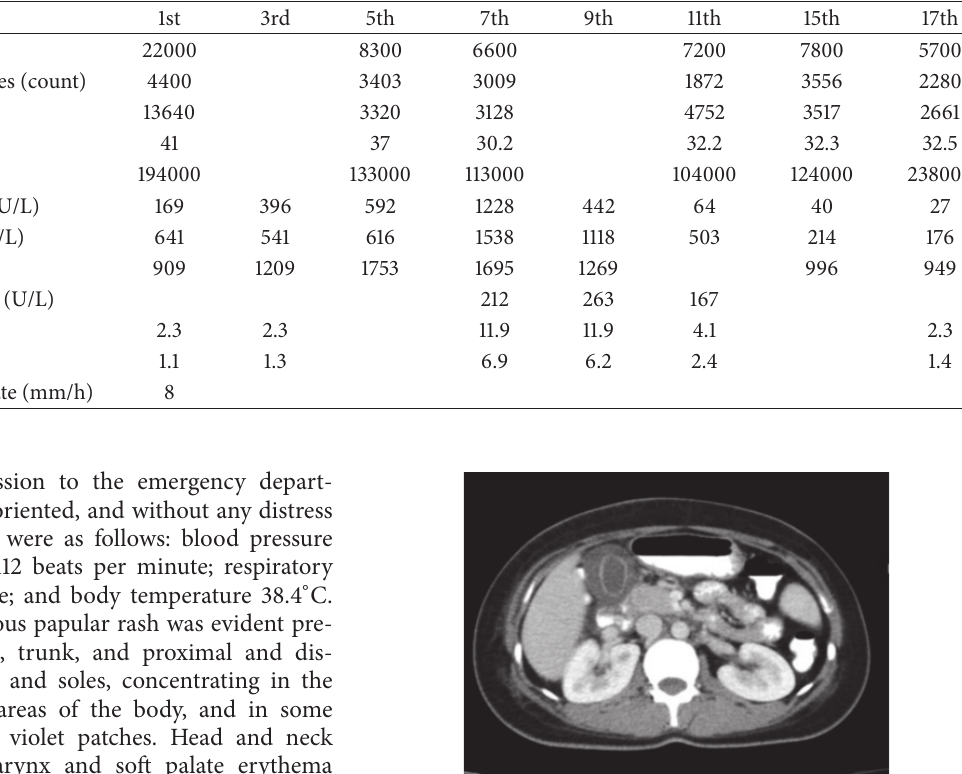
Table 1: Laboratory test results on admission and during the course of hospitalization.